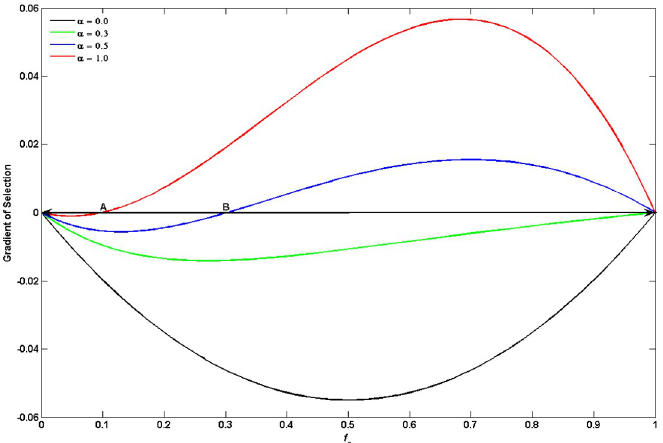
Fig 1. Gradient of selection for the public goods game in well-mixed populations. It shows the results obtained under different values of α . With the increasing of α , the evolution of cooperation is improved effectively. Parameters are r = 3.9, M = 1 and n =